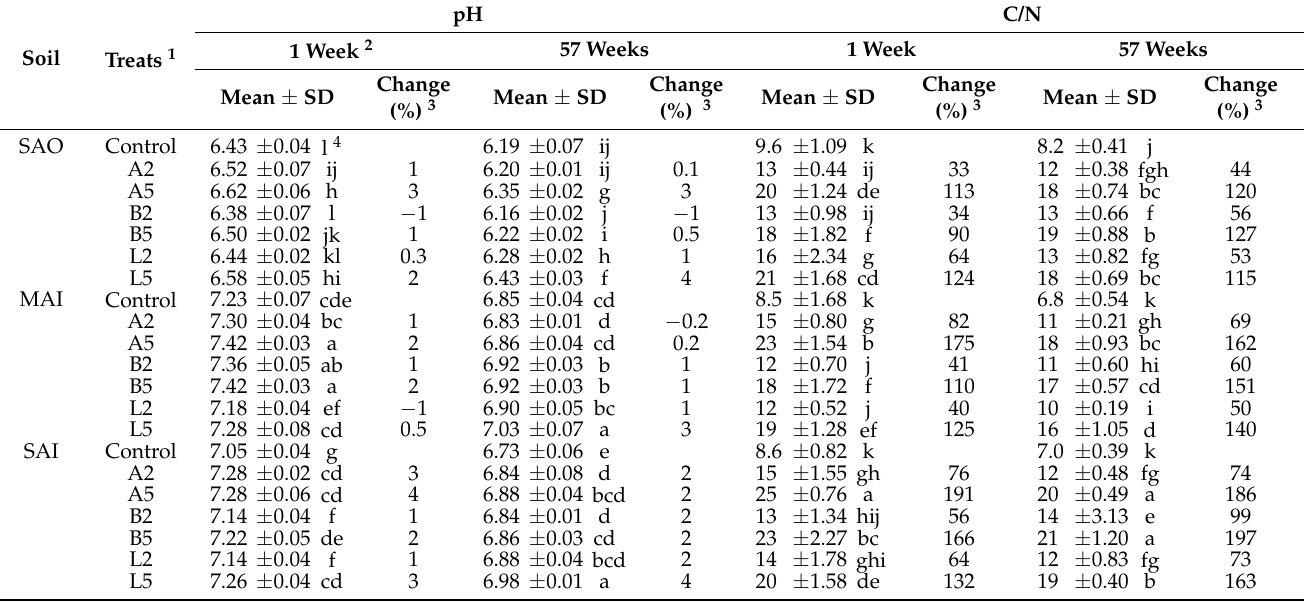
Table 4. Significant test of soil pH and C/N ratio at 1 week and 57